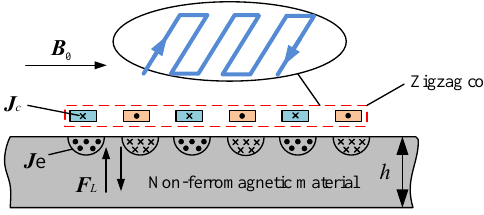
Figure 1. Schematic diagram of EMUS transducer. Fig. 1 Schematicdiagram of electromagnetic ultrasonic transducer